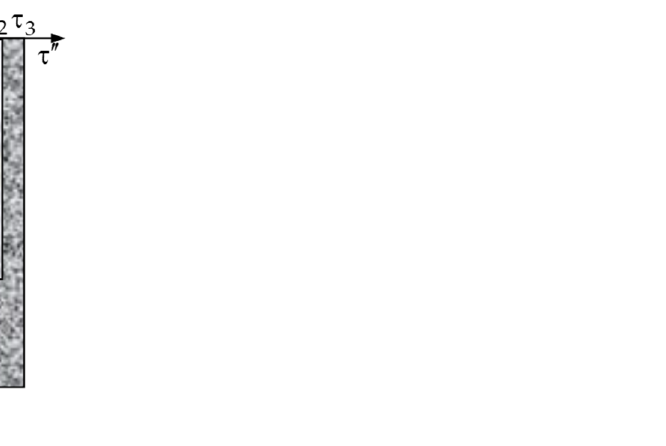
Figure 14. Schematic representation of set of integration regions in the points τ = τ 1 , τ = τ 2 , τ = τ 3 for